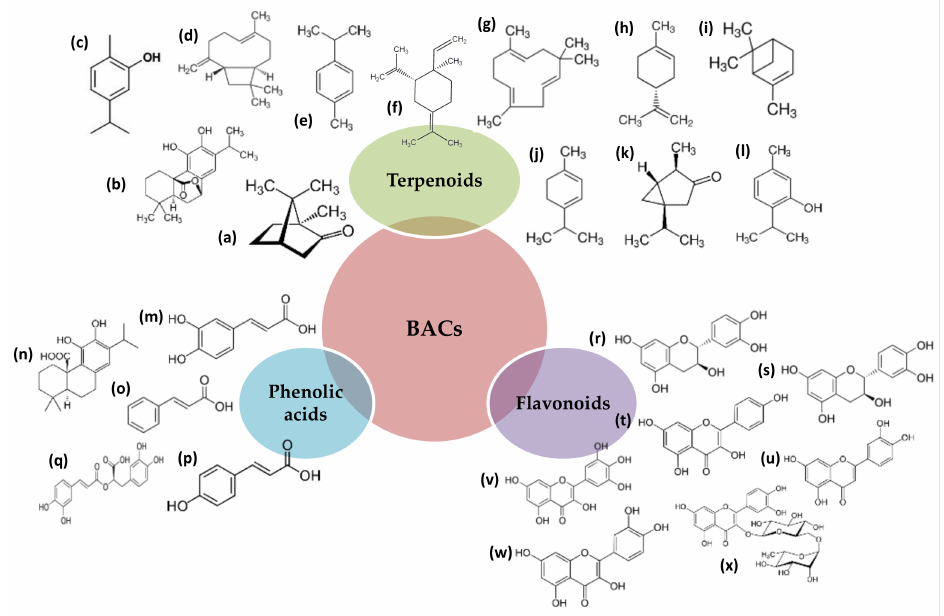
Figure 1. Main bioactive compounds (BACs) present in different plants extracts. ( a ). Camphor, ( b ). Carnosol, ( c ). Carvacrol, ( d ). β -Caryophyllene, ( e ). ρ -Cymene, ( f ). γ -Elemene, ( g ). α -Humelene, ( h ). Limonene, ( i ). α -Pinene, ( j ) . α -Terpinene, ( k ) . α -Thujone, ( l ). Thymol, ( m ). Caffeic acid, ( n ). Carnosic acid, ( o ). trans -Cinnamic acid, ( p ). ρ -Coumaric acid, ( q ). Rosmarinic acid, ( r ). Catechin, ( s ). Epicatechin, ( t ). Kaempferol, ( u ). Luteolin, ( v ). Myrcetin, ( w ). Quercetin, ( x ).